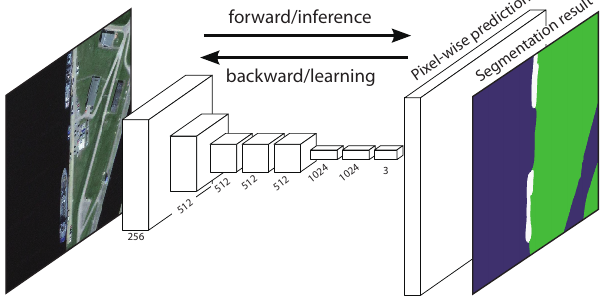
Figure 1. A typical FCN, each cuboid indicating an output matrix of a convolution layer. The numbers indicate the size of the 3rd dimension of each cuboid, or equally, the number of kernels of the corresponding